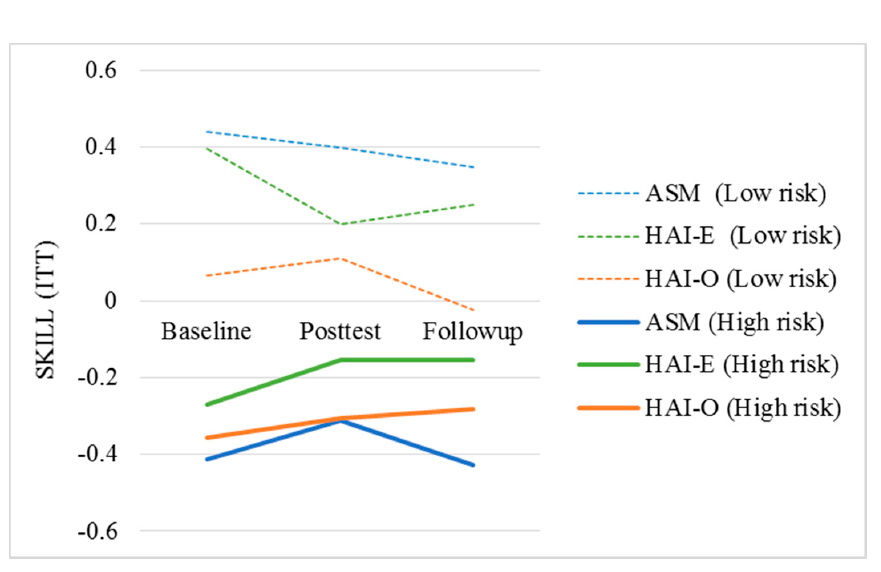
Table 3. Regression analyses modeling moderation effects of mood risk and treatment condition on students’ learning and study strategies SKILL.